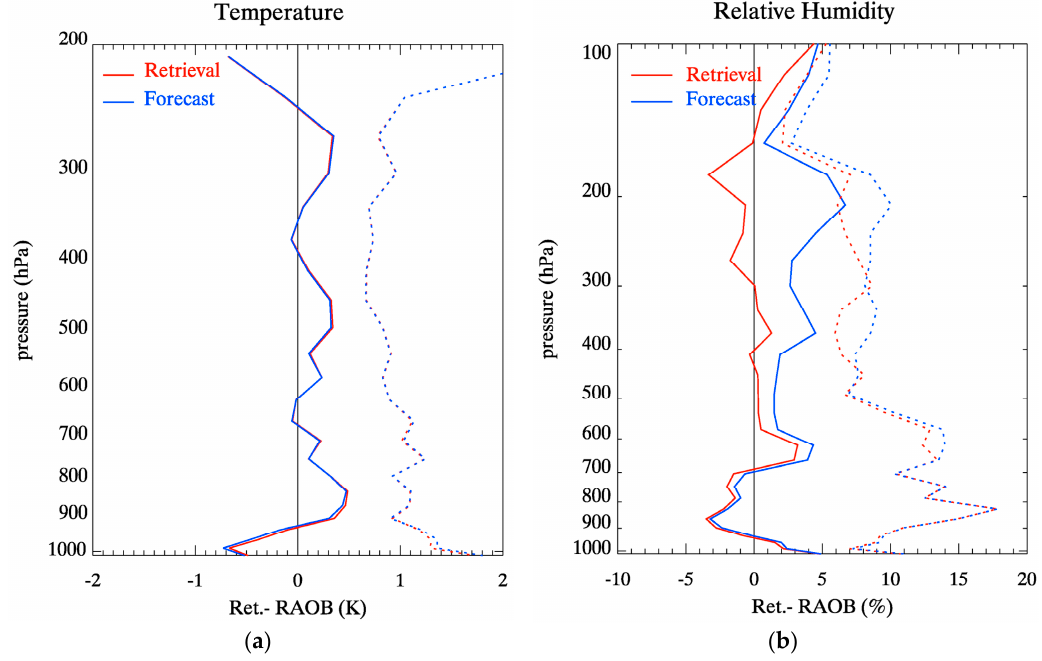
Figure 2 Figure 12. The bias ( solid ) and RMSE ( dotted ) profiles for ( a ) temperature and ( b ) relative humidity between radiosonde and retrieval ( red ) and UM forecast as background ( blue